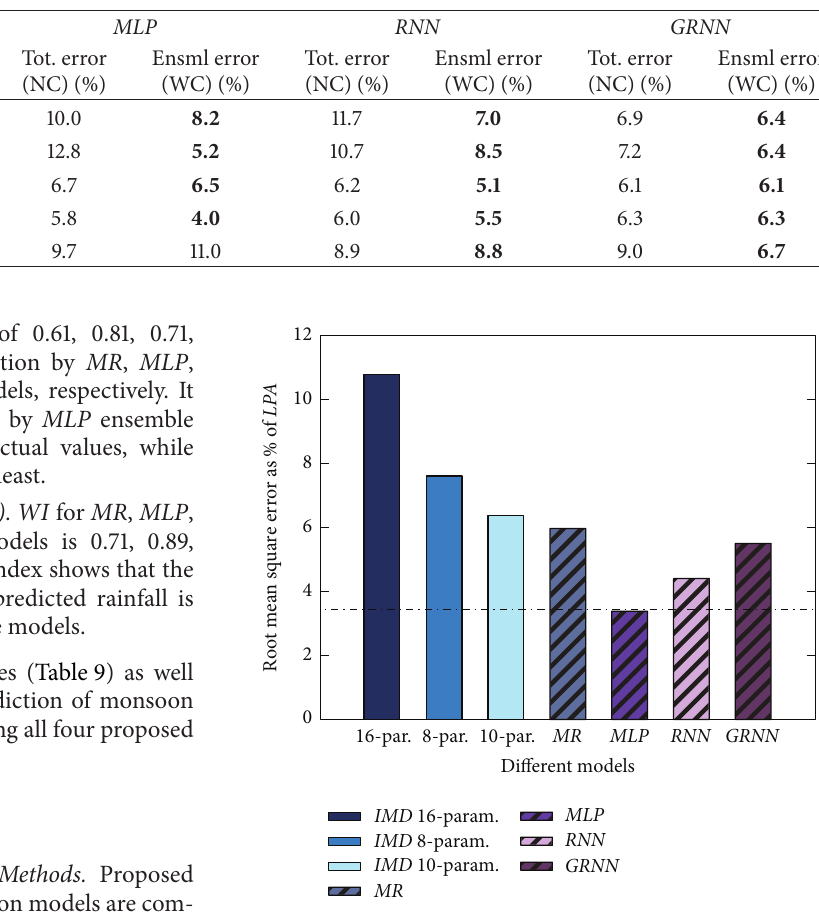
Table 10: Comparison of absolute errors for rainfall prediction by proposed ensemble models (Ensml) with clustering (WC) approach to standard method with same models without clustering (NC) approach.